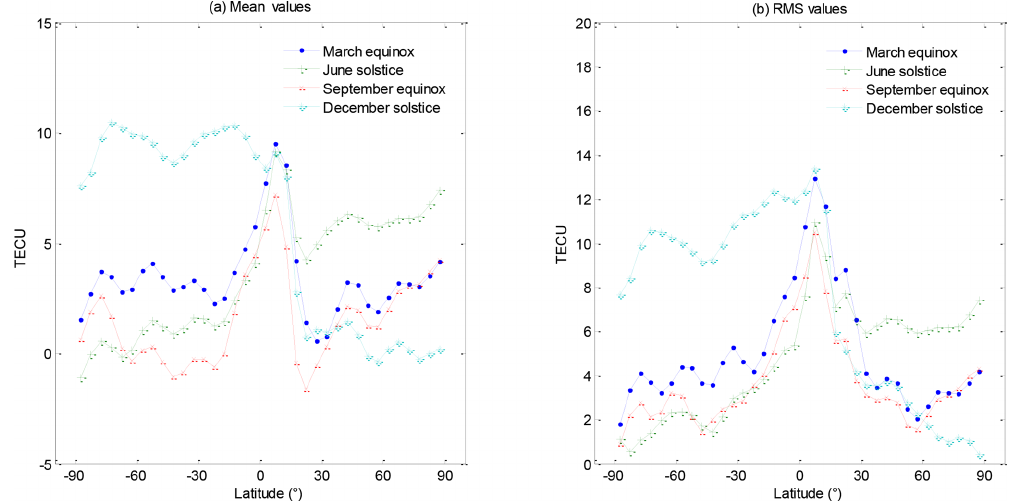
Figure 2. Mean and RMS values of the discrepancies between GIM-TEC and IRI-TEC at different latitudes during four